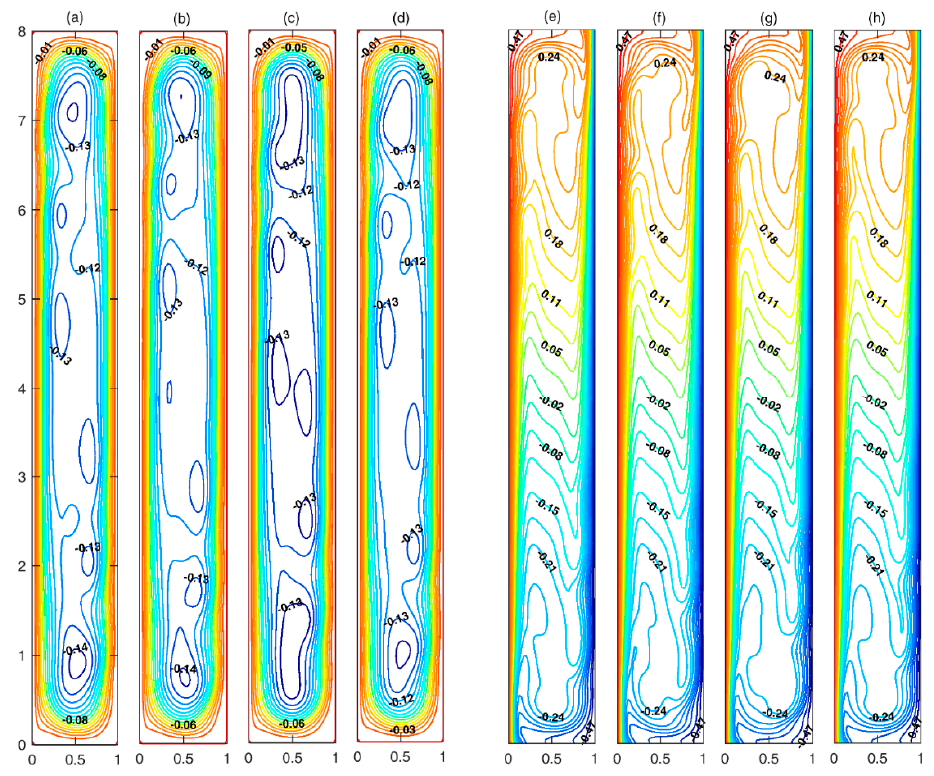
Figure 4. Variation of Streamlines ( a – d ) and Temperature contours ( e – h ) during a time period at time instants 3486.7, 3487.9, 3489.1, 3490.2 ND time units respectively of a total time period of 3.412 ND time units. Point data: